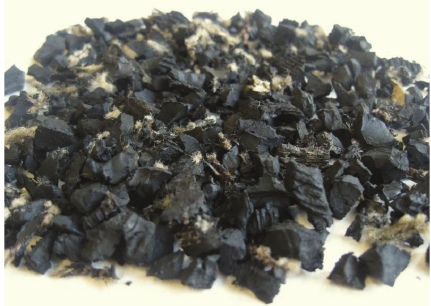
Figure 1: Recycled ground rubber.